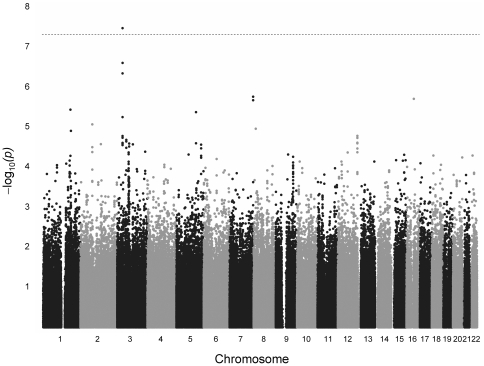
The –log P value (lambda adjusted) of the allelic genetic model for each single nucleotide polymorphism (SNP) according to location on the 22 autosomal chromosomes.Horizontal line indicates the 5×10−8 P value threshold for genome-wide significance.